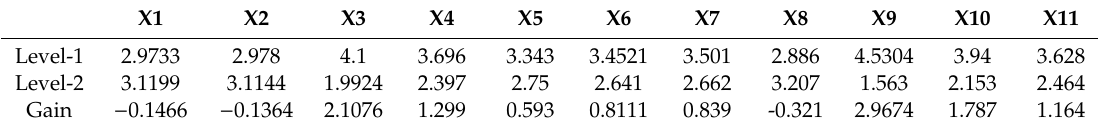
Table 11. Average S / N ratios and gain for each